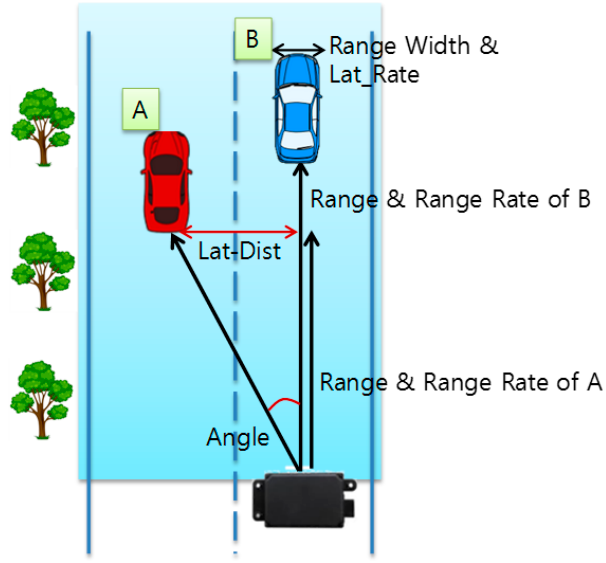
Figure 5. Extracted information from vehicular radar.